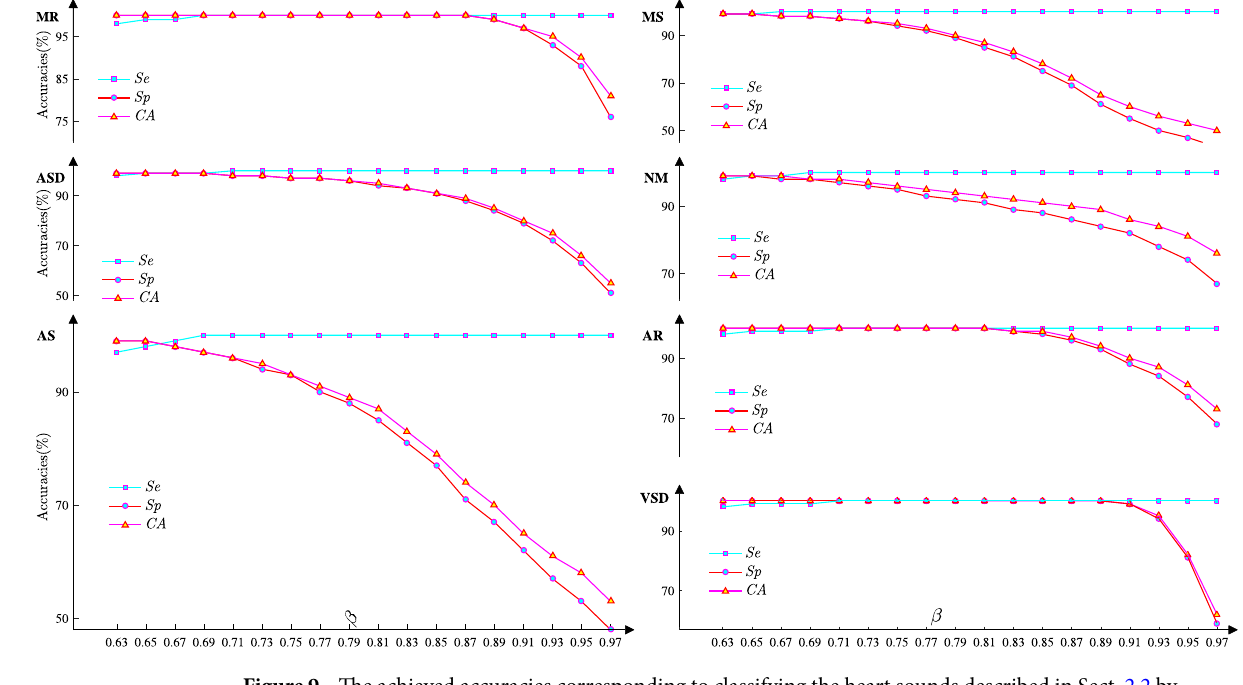
Figure 9. The achieved accuracies corresponding to classifying the heart sounds described in Sect. 2.2 by setting β form 0.63 to 0.97 with a step of k th Step 3: The confidence level (β k ) determination. Actually, the k th confidence region, as specified by the k th desired confidence level β , is surrounded by the k th ellipsoid, and this relation is expressed as k